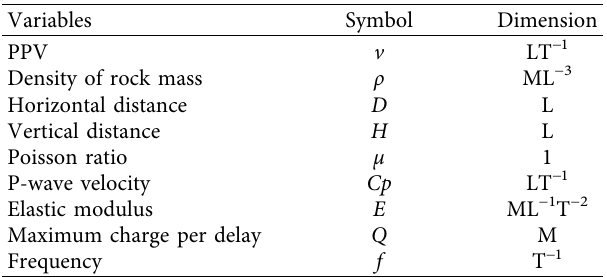
Table 5: Variables related to PPVs on the slope surface subjected to blasting